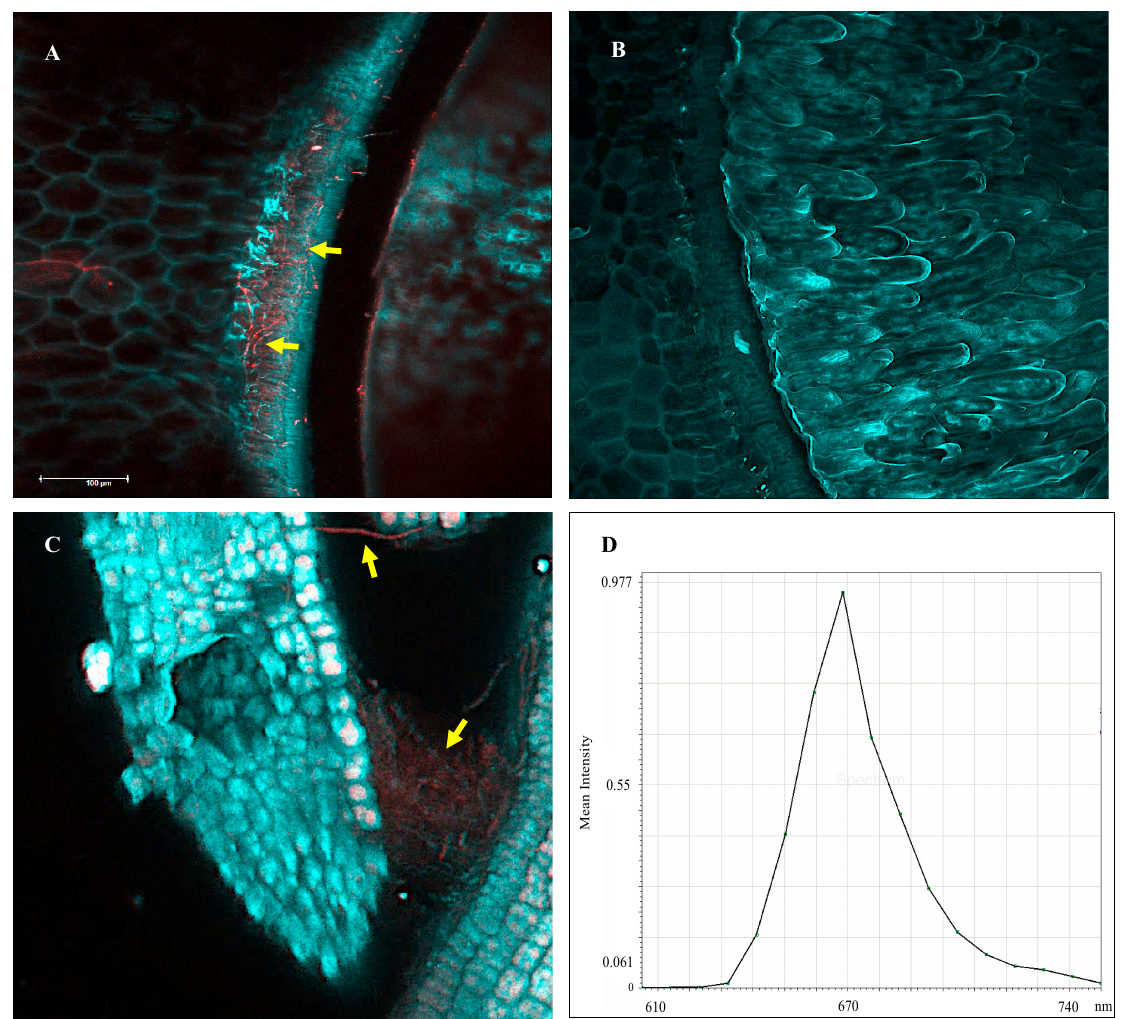
Figure 11. Fluorescent in situ hybridization (FISH) applied on an Ipomoea carnea positive seed hilum ( A ), negative seed hilum ( B ), and positive hypocotyl ( C ). Probe attachment to fungal mycelia emitted in red and indicated by arrows in ( A , C ). Scale bar—100 μ m. Samples were examined using the confocal microscope, and emission was collected in two image channels: cyan (blue and green) to capture autofluorescence of plant cells and red (650–720 nm) to capture the fungal mycelia hybridized with swnK probe. Probe was excited at 594 nm, and maximum emission was at ~670 nm in red ( D ).